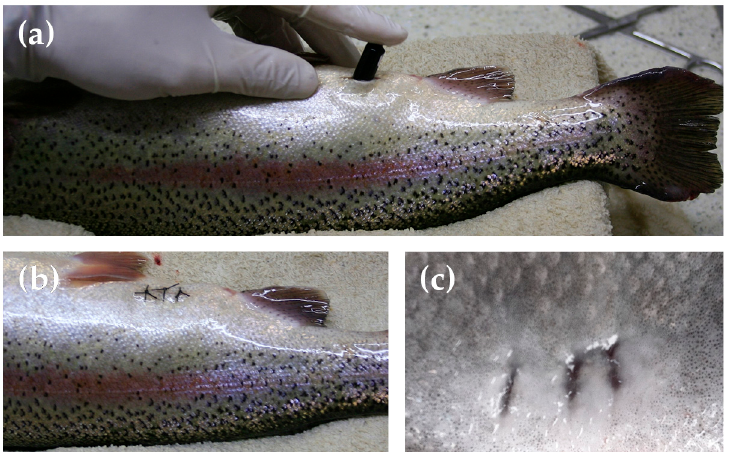
Figure 1. Surgical implantation of a tailbeat accelerometer tag (V9A, Vemco, Nova Scotia) in rainbow trout ( Oncorhynchus mykiss ): ( a ) insertion of the tag in the wound; ( b ) wound sutures; and ( c ) healed wound after 5 days of tag surgical implantation.